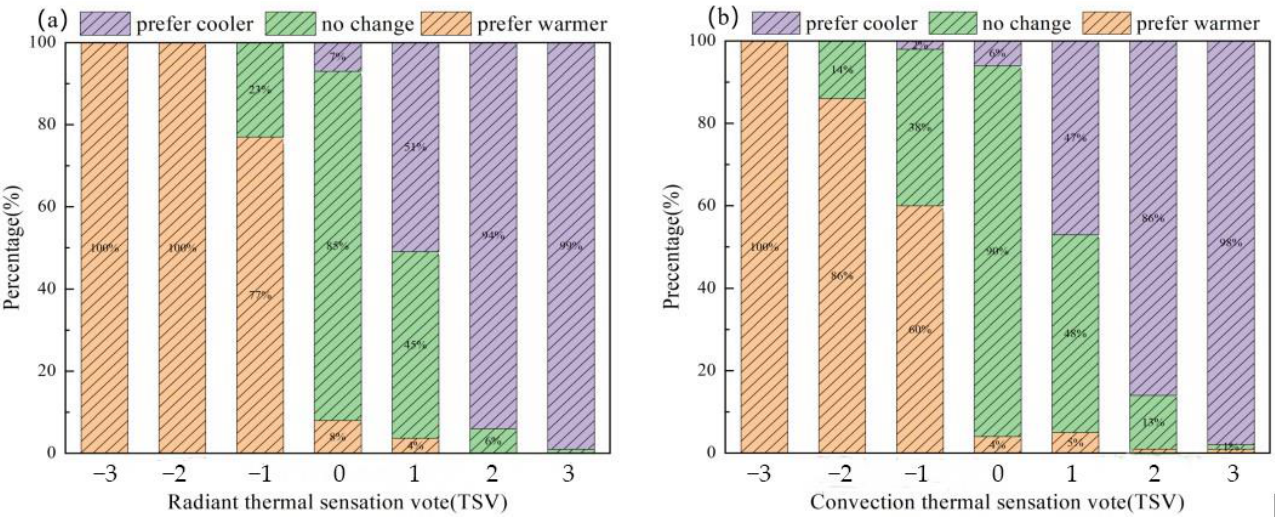
Figure 6. The thermal sensation vote ’ s thermal preference distribution: ( a ) radiant and ( b ) convective heating.